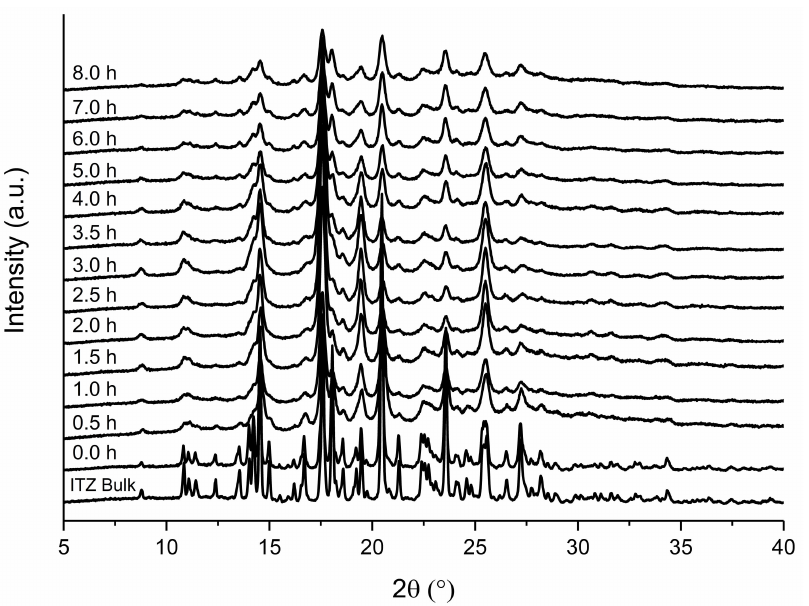
Figure 5. XRPD pattern of F6 in relation to grinding time. Milling was carried out at 4 ◦ C with 1500 rpm and milling beads sized 0.3–0.4 mm. Plots are shifted for a better